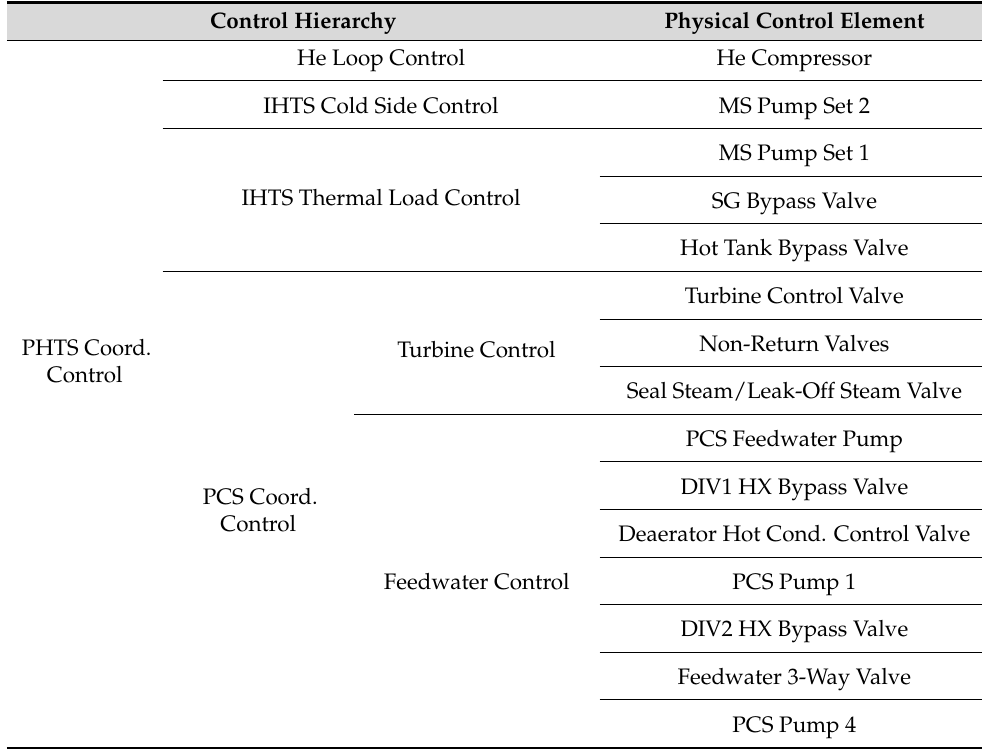
Table 3. Control Hierarchy in PHTS, IHTS and